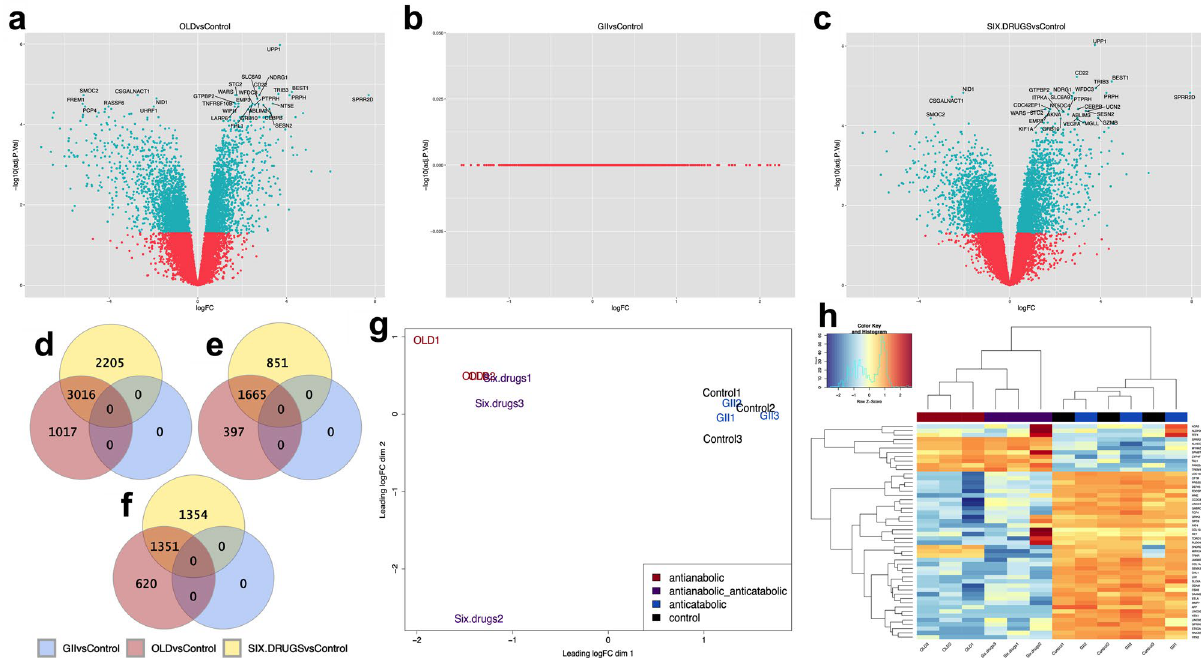
Figure 2. The metabolic treatment generates important changes on the transcriptomic profile. ( a-c ) Volcano plots of the OLD vs control ( a ), GII vs control ( b ) and 6 drugs vs control ( c ) conditions. Blue dots show statistically significant transcripts, and red dots show shared transcripts with no significant differences. The 30 most significant transcripts are indicated with their HUGO symbols in each plot. Blue dots located at the two upper-lateral quadrants indicate biologically and statistically differentially expressed transcripts. ( d-f ) Venn Diagram showing global differentially expressed genes ( d ), up-regulated genes ( e ) and down-regulated genes ( f ) in the OLD vs control, GII vs control, and 6 drugs vs control conditions. ( g ) Multidimensional scaling (MDS) plot of the 12 samples showing clustering between control and GII, as well as between most of the OLD and 6 drugs samples. ( h ) Hierarchical clustering with heatmap plot of the 50 most up-regulated transcripts identified in the 12 samples. Dendrograms showing a cluster between the anti-anabolic (OLD, red) and anti-anabolic + anti-catabolic (6 drugs, purple) samples, while the anti-catabolic (GII, blue) are mixed with the control samples (vehicles of the 6 drugs, black). N = 3 independent experiments. Statistical analyses were performed with one-way analysis of variance (ANOVA) with Bonferroni correction. OLD: Orlistat + lonidamine + DON; GII: Growth hormone + insulin + indomethacin; 6 drugs: OLD +